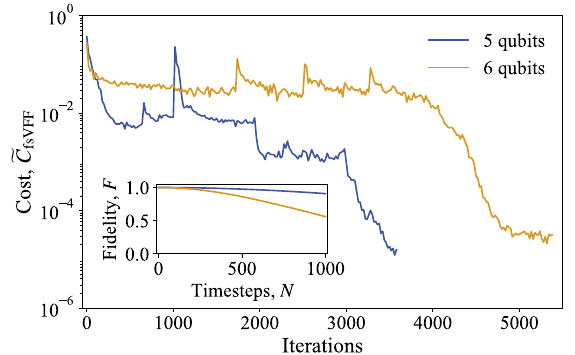
Fig. 5 Randomized Training. The 5 (6) qubit XY Hamiltonian with initial state 11100 j ið 111000 j